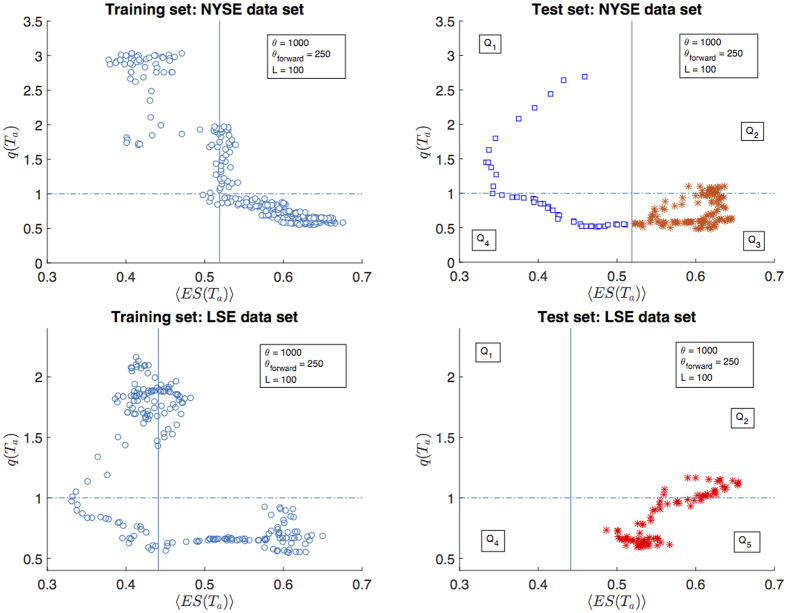
Partition of data into training (left graphs) and test (right graphs) set.Training sets are used to regress Y(Ta) against 〈ES〉(Ta), in order to estimate the coefficents in the logistic regression and therefore identify the regression threshold, shown as a vertical continuous line. The test sets are used to test the forecasting performance of such regression on a subset of data that has not been used for regression; the model predicts Y(Ta) = 1 (q(Ta) > 1, blue squares in the figure) if 〈ES〉(Ta) is less than the regression threshold, and Y(Ta) = 0 (q(Ta) < 1, red stars in the figure) otherwise.